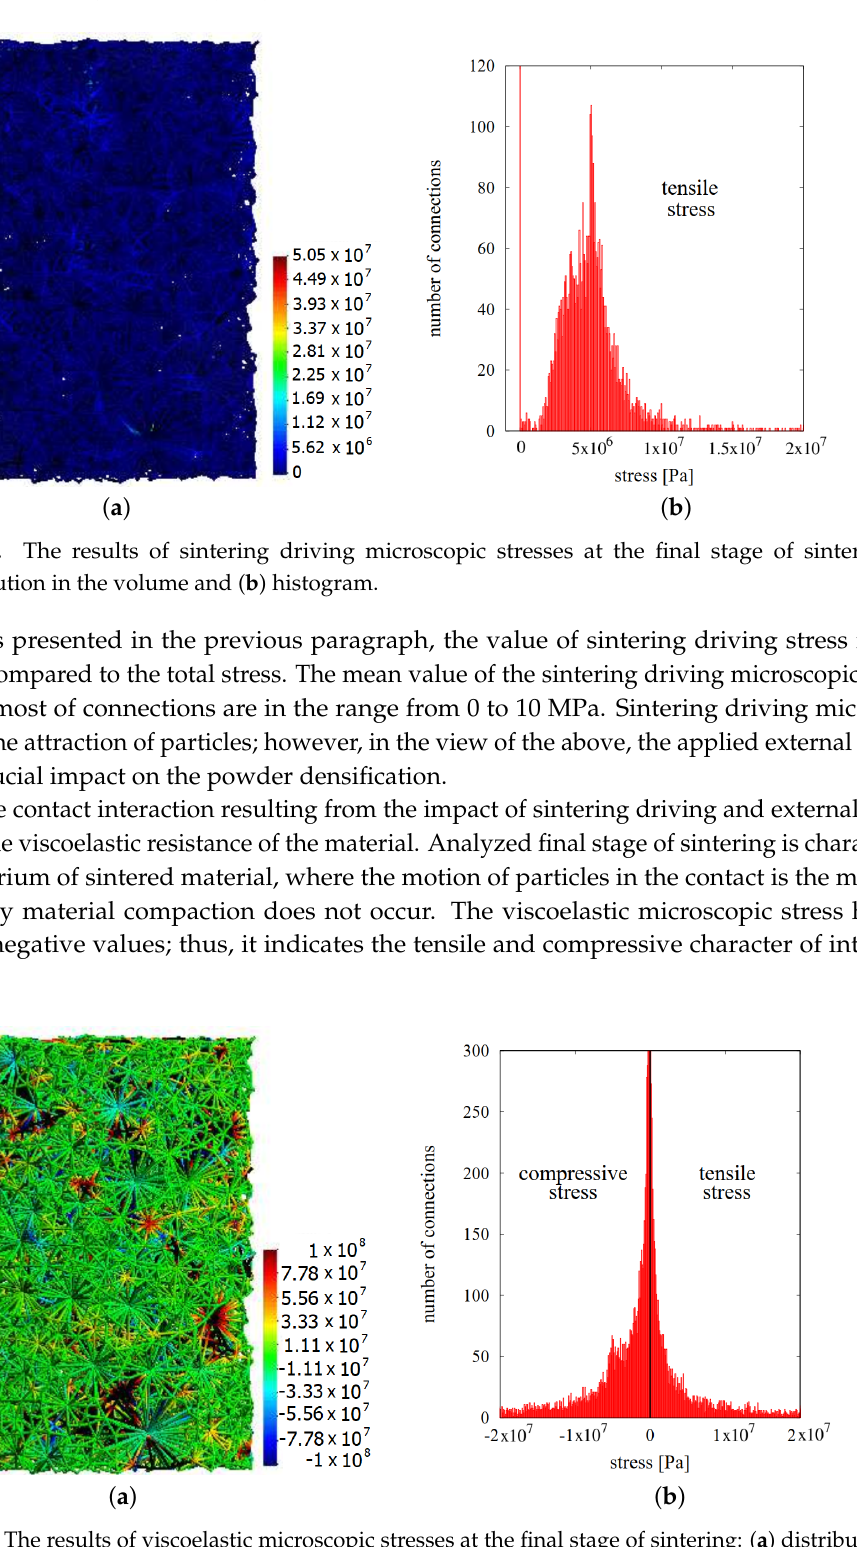
Figure 12. The results of viscoelastic microscopic stresses at the final stage of sintering: ( a ) distribution in the volume and ( b )